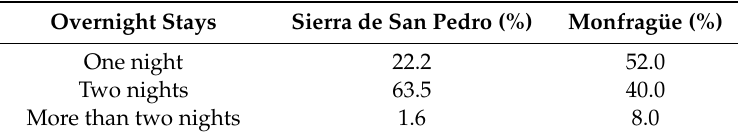
Table 11. Hunting tourists’ overnight